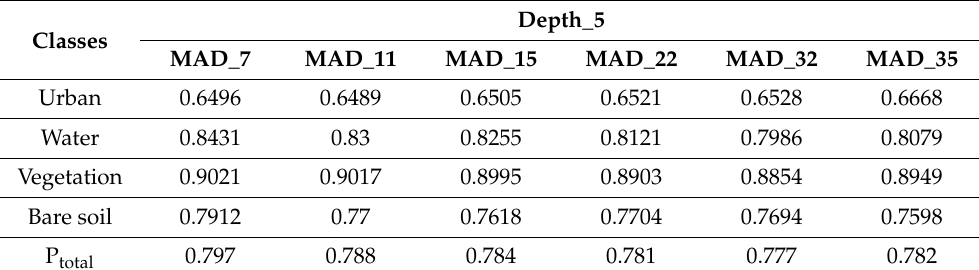
Table 17. Probabilities for classes and total probabilities of correct classification for depth 5 and different